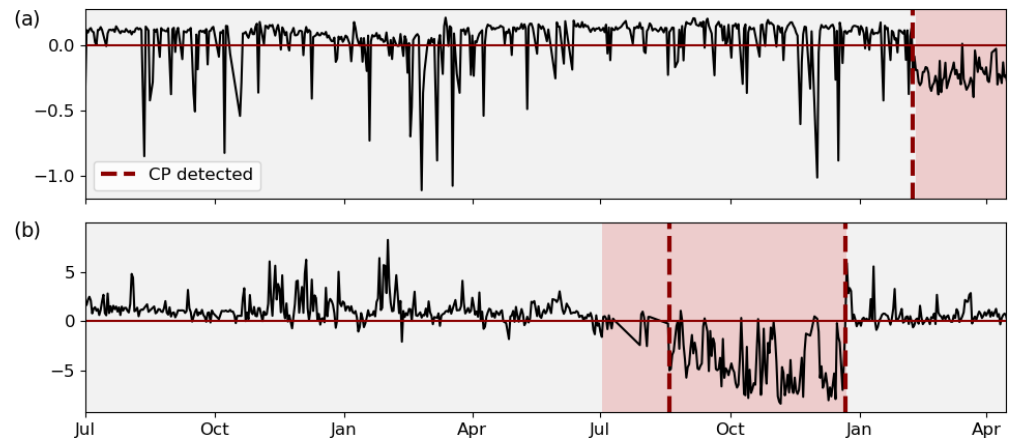
Figure 8. Examples of successful CP detection in gear oil pressure (a) and nacelle temperature (b) . Each change in background colour indicates a true CP; each dashed line indicates a detected CP.